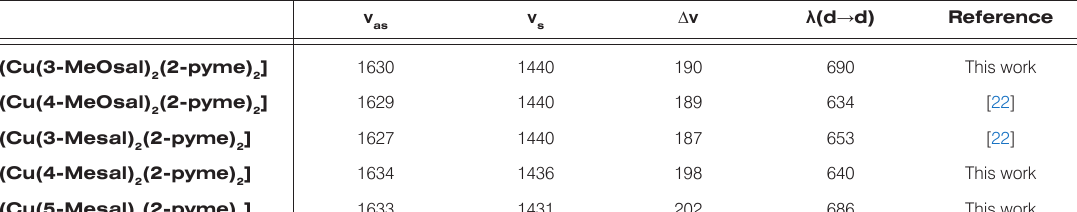
Table 2. Wavenumbers (cm –1 ) of the COO - stretches and solid-state electronic spectra (nm) for complexes ( 1–5 ).